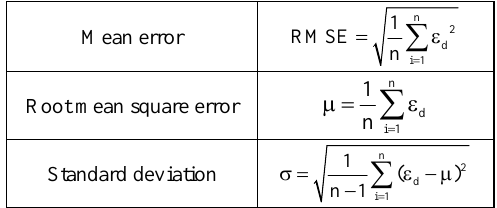
Table 5. Solid-rigid transformation parameters between TLS and ITS.